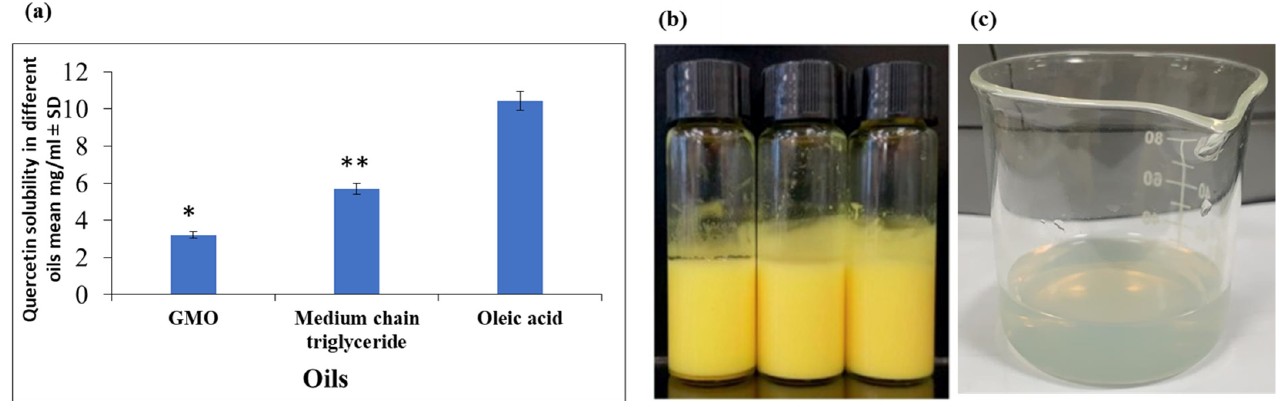
Figure 1. ( a ) Selection of oil for QR-NE preparation (there is a significant difference between GMO and MCT solubility results from oleic acid’s results at p = 0.068 * and 0.041 **, respectively). ( b ) Quercetin emulsion using the selected oil (the composition as in the methods section). ( c ) Quercetin nanoemulsion after homogenization. Table 1. Formulation parameters affect the particle size and entrapment efficiency.